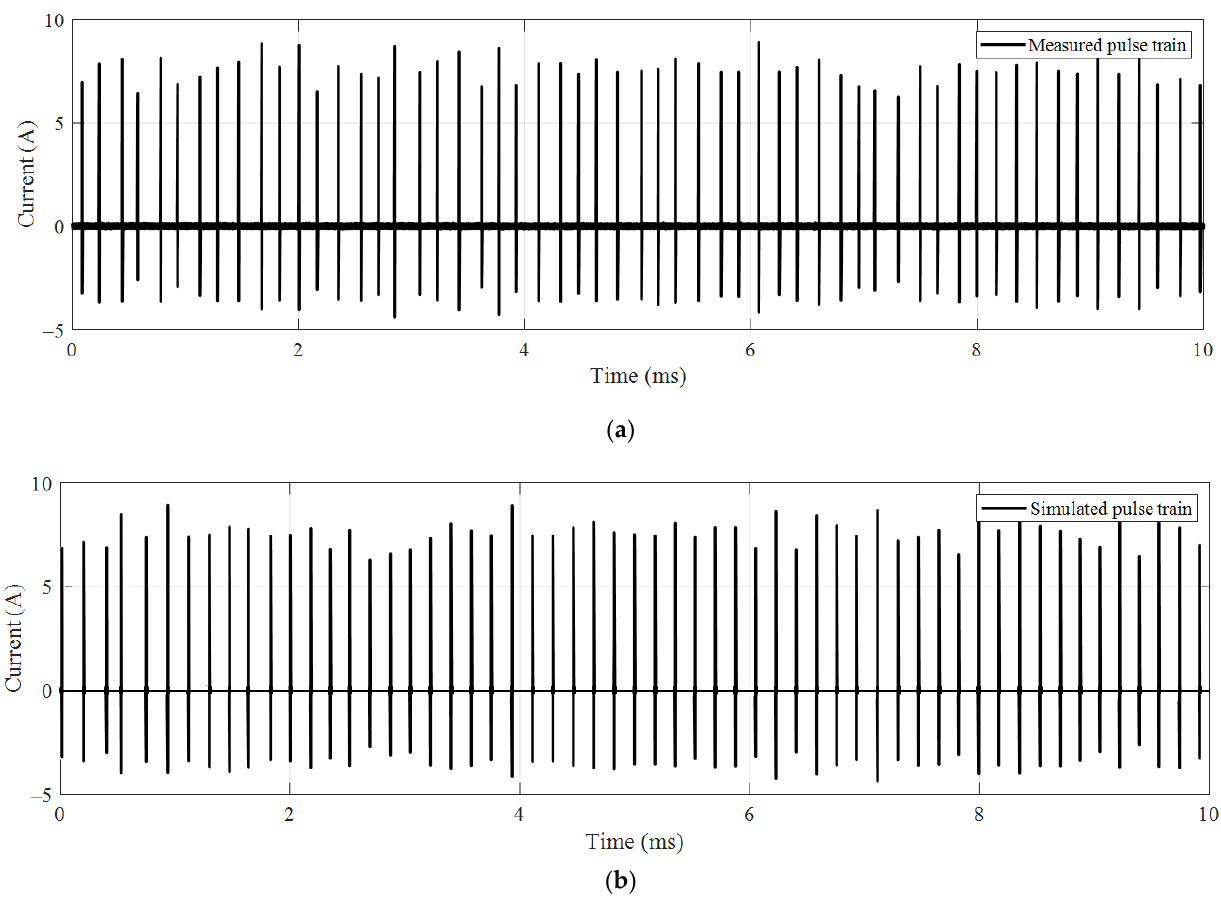
Figure 13. Comparison of the simulated and measured current pulse train: ( a ) measured pulse train with t in ̅ = 0.185 ms and s in = 0.064 ms; ( b ) simulated pulse train with μ = 0.214 and σ = 0.050 for the Extreme Value distribution of t i .